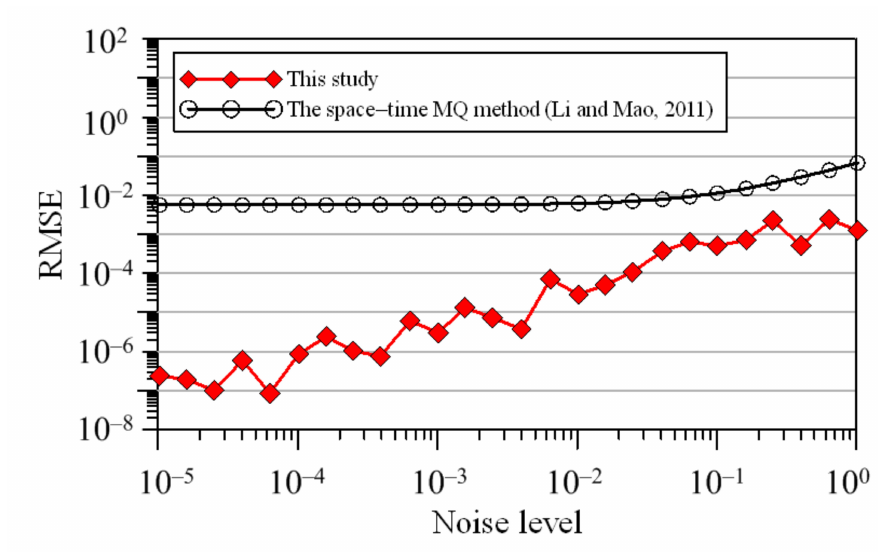
Figure 14. The RMSE versus di ff erent noise